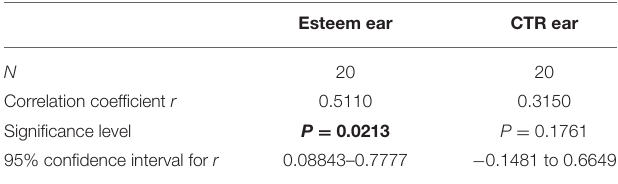
TABLE 3 | Correlation of hearing loss grade at follow-up vs. the pre-operative one in the Esteem implanted ear ( p = 0.0213) and in the contralateral one ( p =